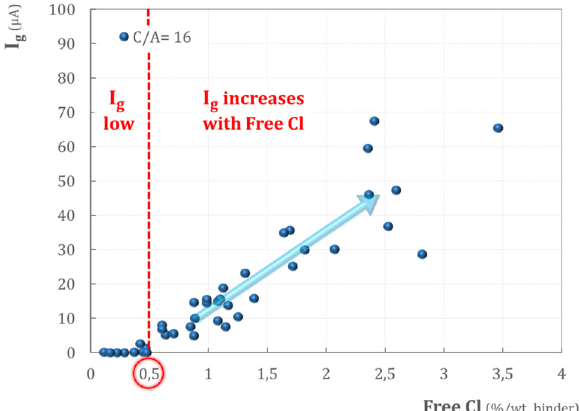
Figure 3. Galvanic current I g between the apparent anode and the cathode as a function of the concentration of free chlorides at the